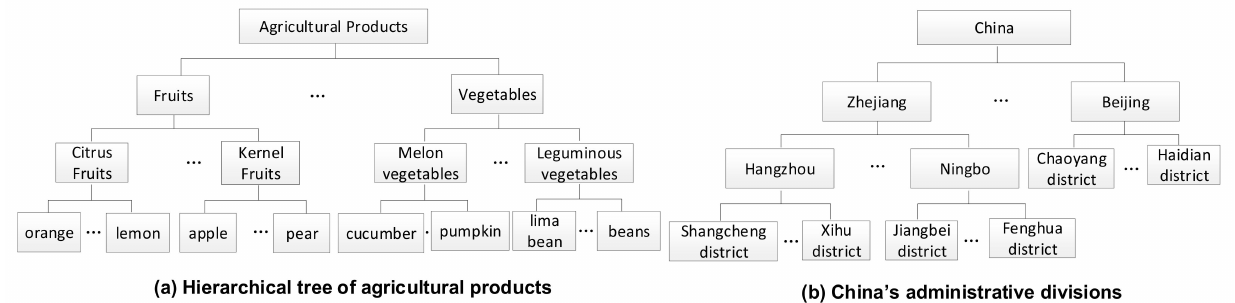
Figure 2. ( a ) Classification hierarchy of Chinese agricultural products and ( b ) geographical hierarchy of